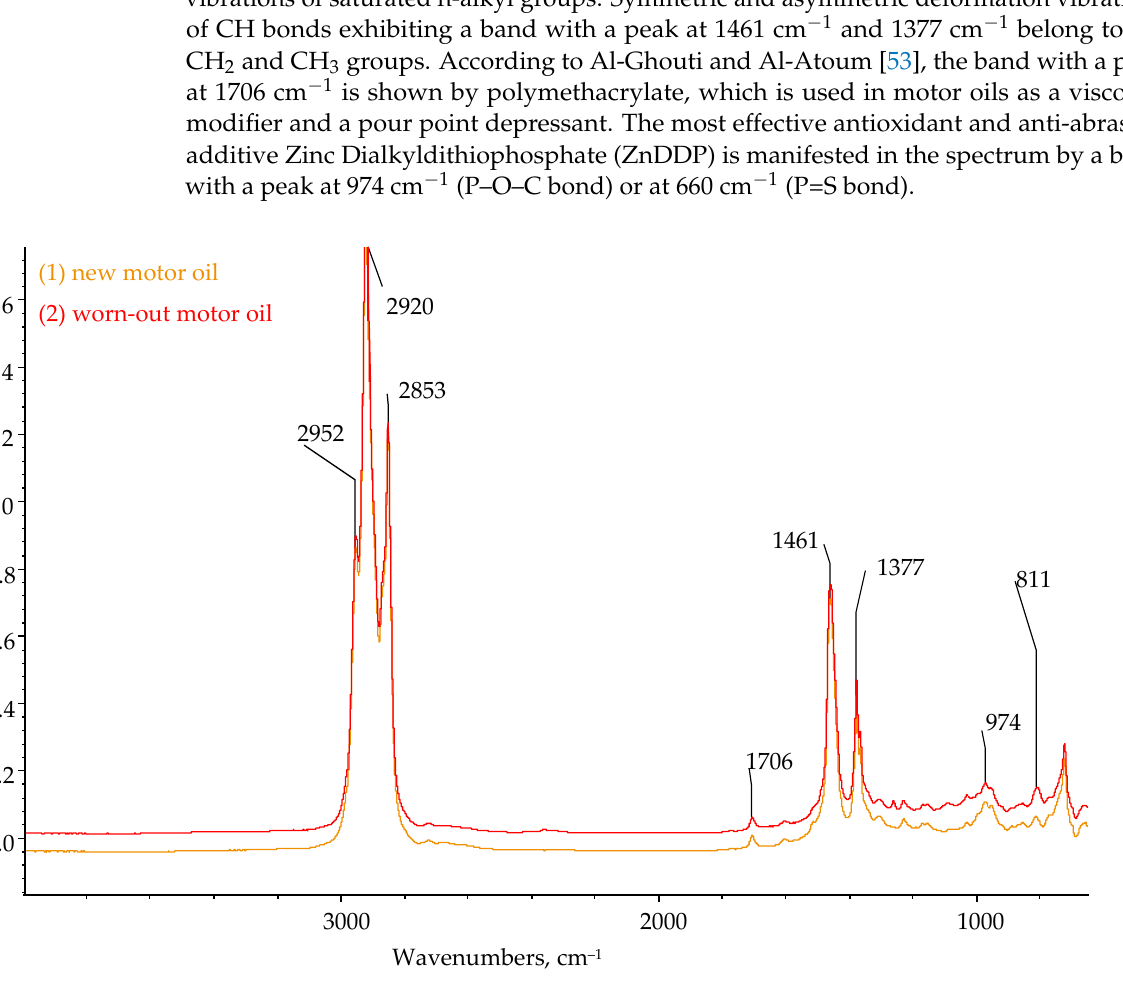
Figure 1. FTIR spectra in the measured range 4000–650 cm − 1 , (1) new motor oil with KV100 ◦ C = 13.950 mm 2 s − 1 , (2) worn- out oil with KV 100 ◦ C = 10.743 mm 2 s − 1.